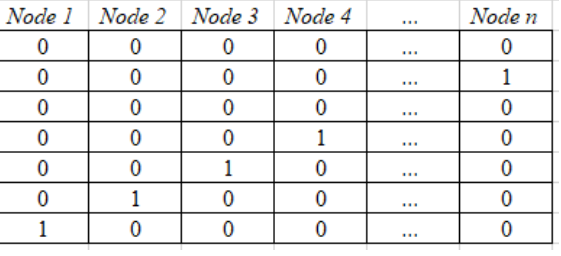
Figure 6. Population Configuration